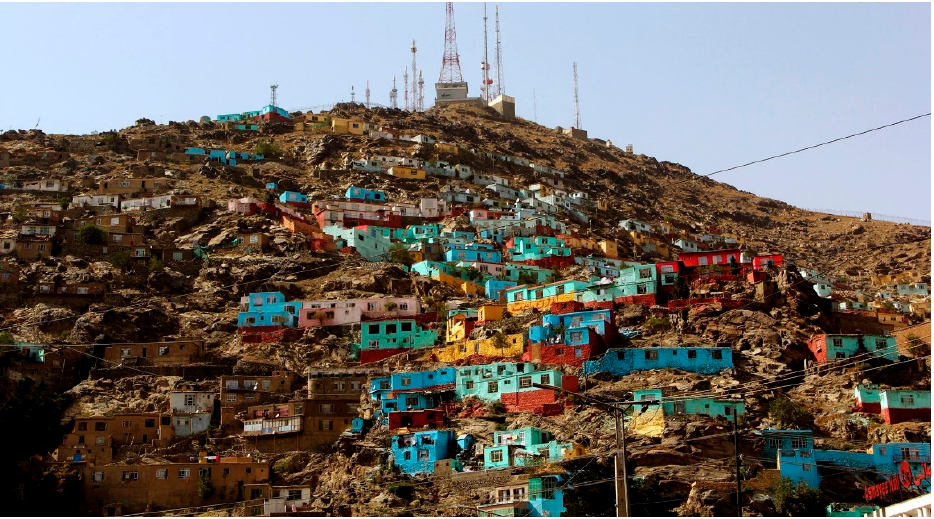
Figure 6. A view showing traditional settlement sprawling up a mountain slope. Photo by Capital Region Independent Development Authority (CRIDA), 2018; used with permission.